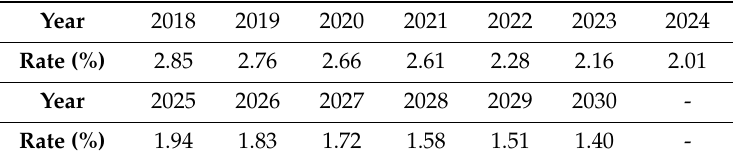
Table 5. PV installed capacity, PV generation, and generation time for 2016, 2017, and 2018.